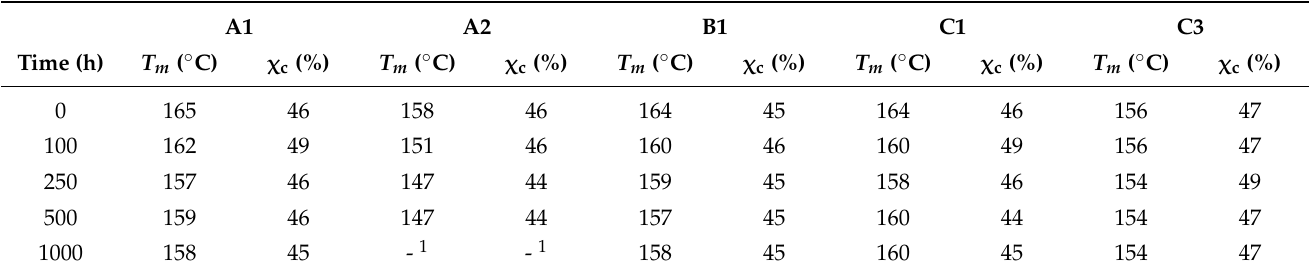
Table 3. The temperature of the main melting peak and χ c of the PP layers as a function of the time of accelerated photoaging at 24 ◦ C. Values refer to the second